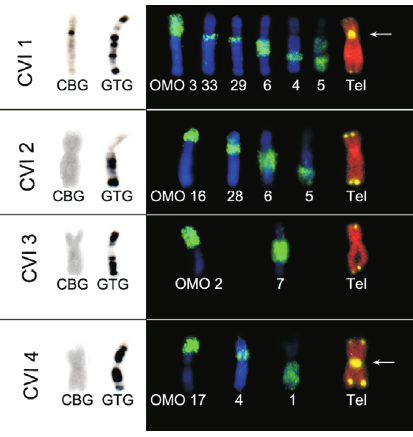
Figure 4 - CBG and GTG-banding pattern and hybridizations with OMO and telomeric probes in four pairs of C. vivoi (CVI 1 to 4). Arrows indicate ITS.